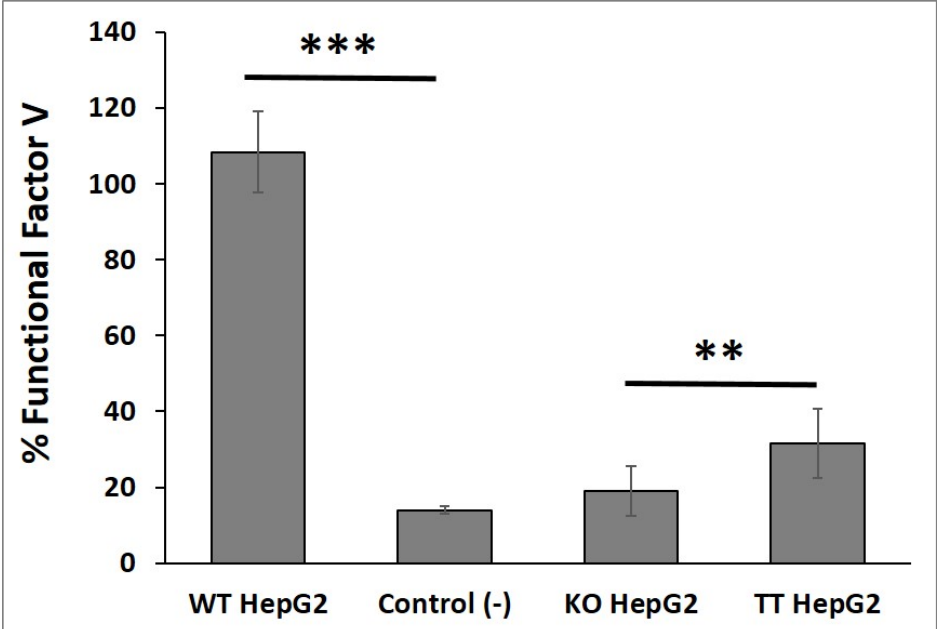
Figure 6. Functional factor V coagulometry assay. Functional factor V secreted by different cell lines (WT HepG2, KO HepG2 and TT HepG2). Control (-): Oval cells and SW480 as negative controls. Figure presented as mean ± SD ( n = 4) (*** p < 0.001; ** p < 0.01).